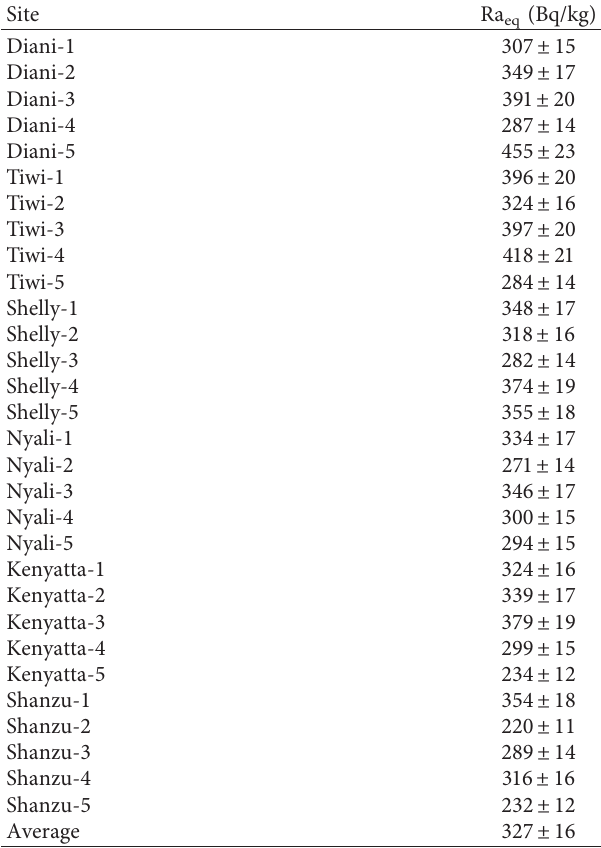
Table 2: The values of radium equivalent for each of the thirty samples and average of each beach in this work.